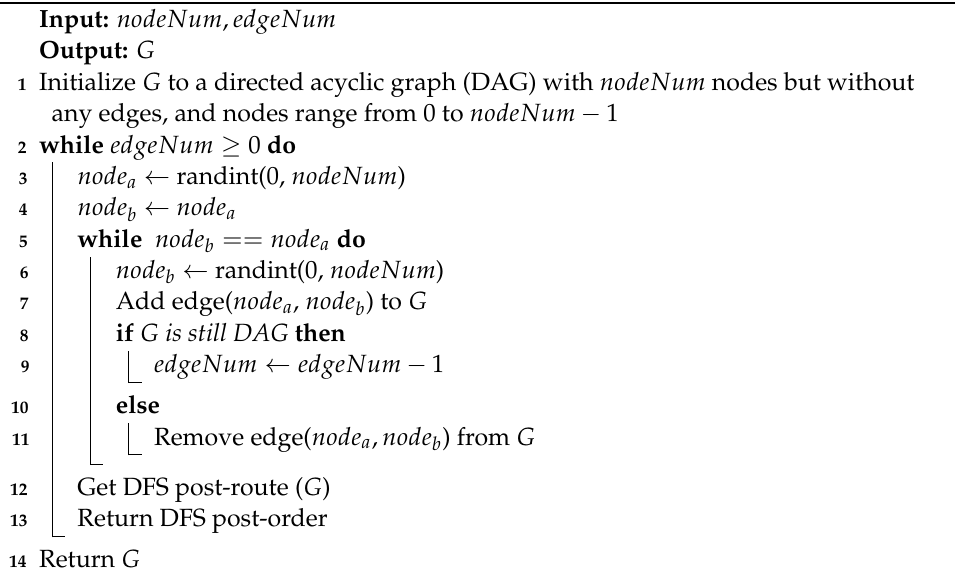
Algorithm 1: Generate a random directed acyclic graph